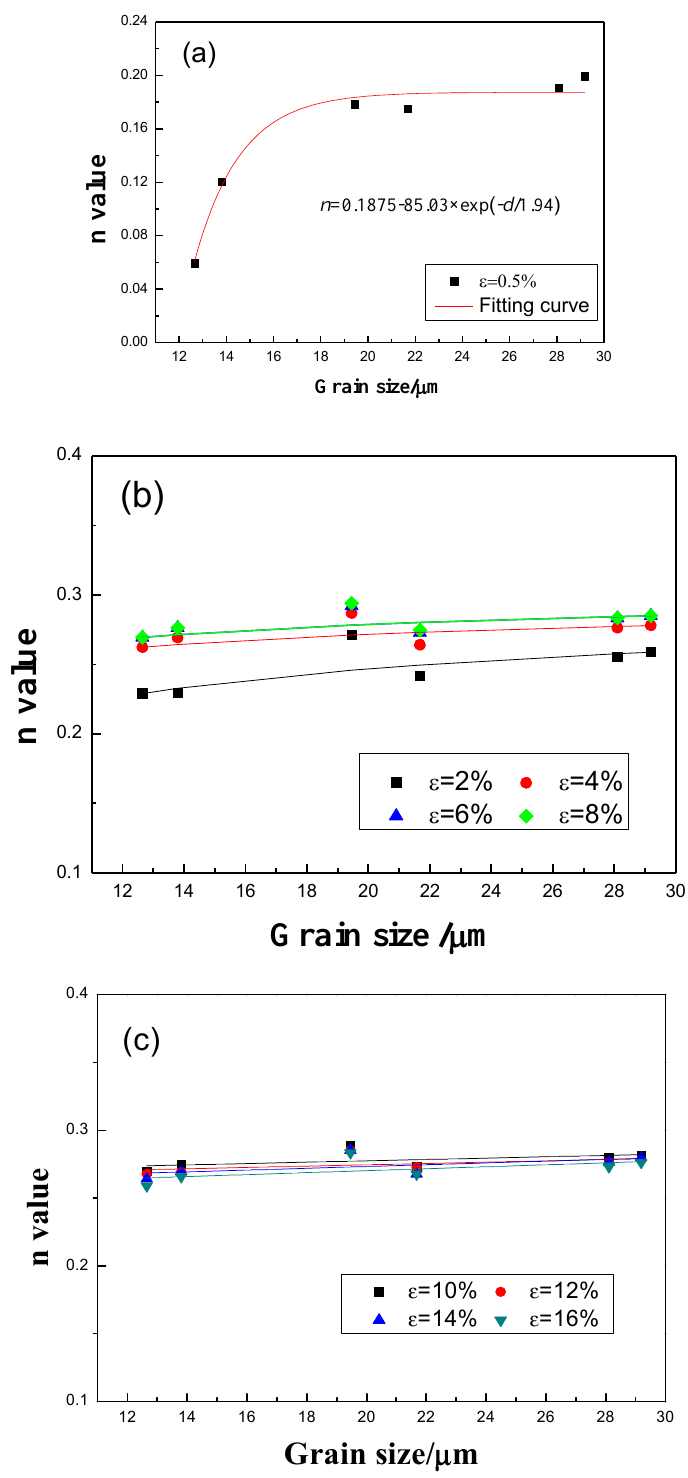
Figure 8. Relationship between grain size and n value at different target strains: ( a ) ε = 0.5%; ( b ) ε = 2%, 4%, 6%, and 8%; ( c ) ε = 10%, 12%, 14%, and 16%. Table 2. Parameters in Equation (6) for the n value at different target strains.